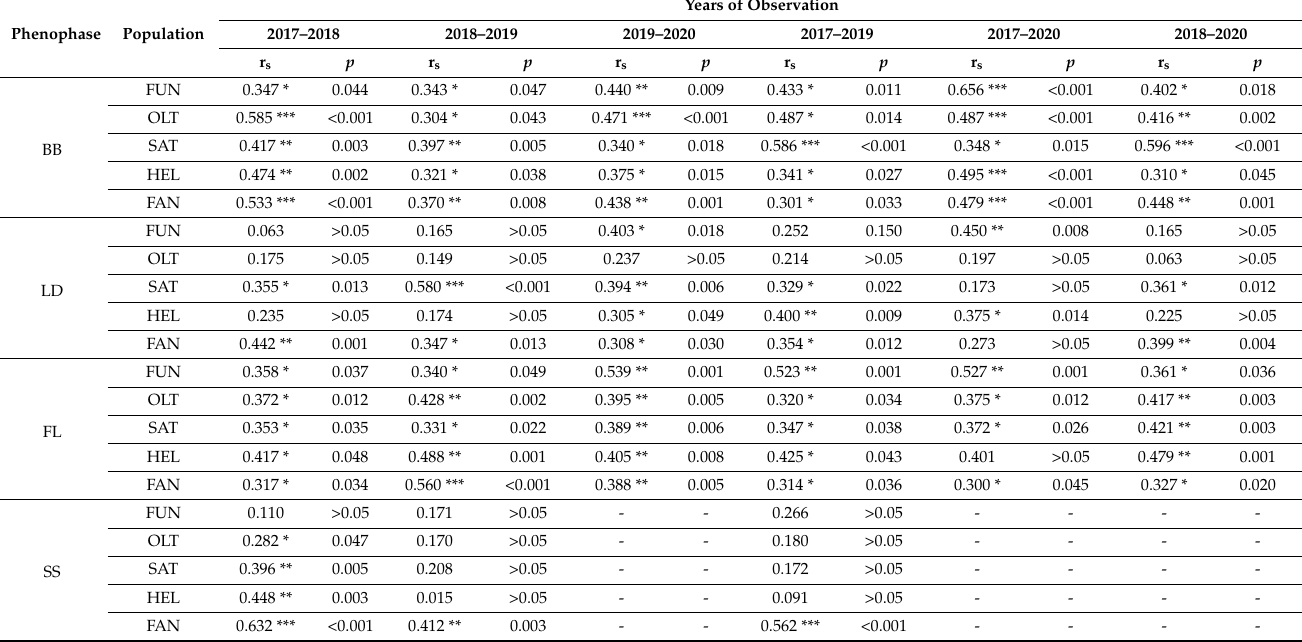
Table 8. Spring and autumn phenophase correlations based on the phenological records.